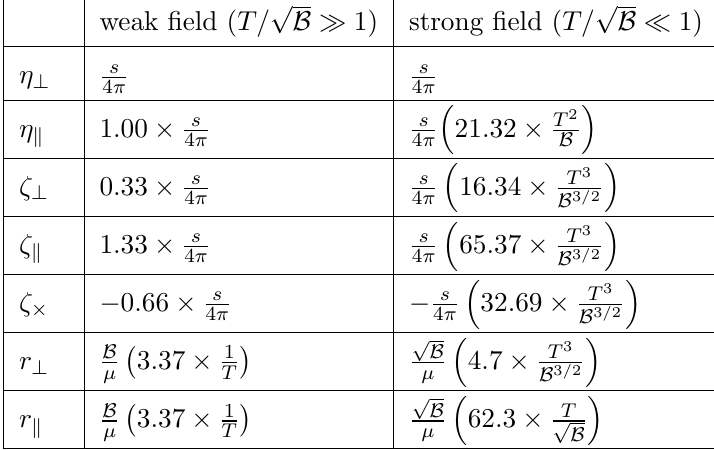
Table 2 . Approximate asymptotic behaviour of all (cid:12)rst-order transport coe(cid:14)cients in weak- and strong-(cid:12)eld limits. The temperature-dependent scaling of the shear viscosities at low temperature agrees with what was reported in ref. [29].